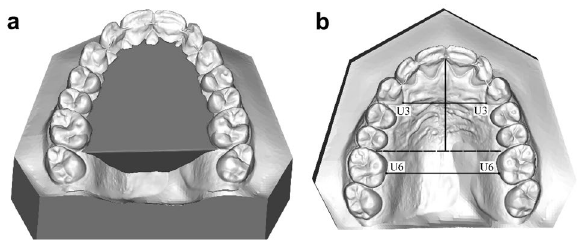
Figure 1. Analysis of 3D digital models. ( a ) Palatal volume. ( b ) Intercanine width (U3–U3) and intermolar width (U6–U6) measured at the gingival level. Arch depth is measured by tracing a line perpendicular to